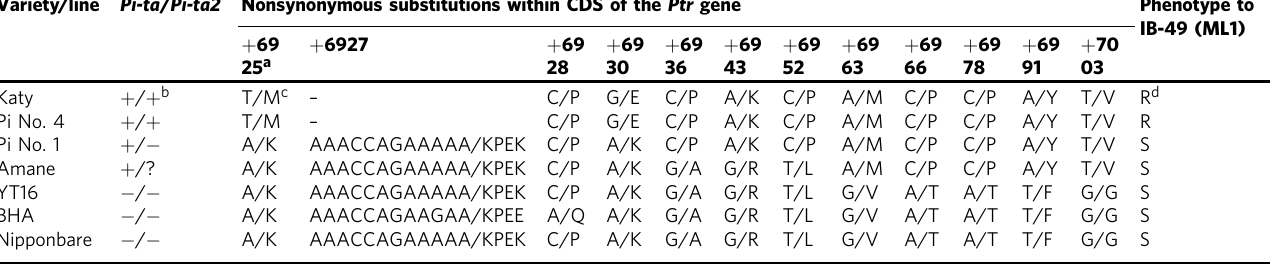
Table 2 Sequence analyses of the Ptr gene in seven differential rice varieties/lines, and their disease reactions Variety/line Pi-ta / Pi-ta2 Nonsynonymous substitutions within CDS of the Ptr gene